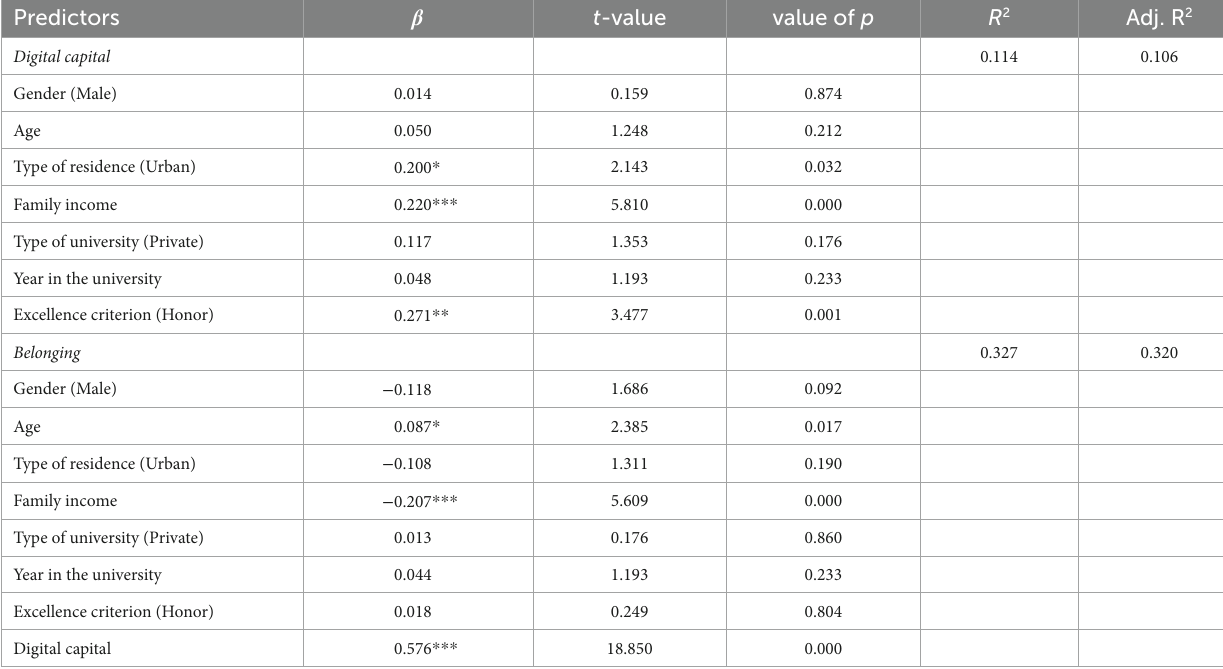
TABLE 7 Direct effects on digital capital and belonging.